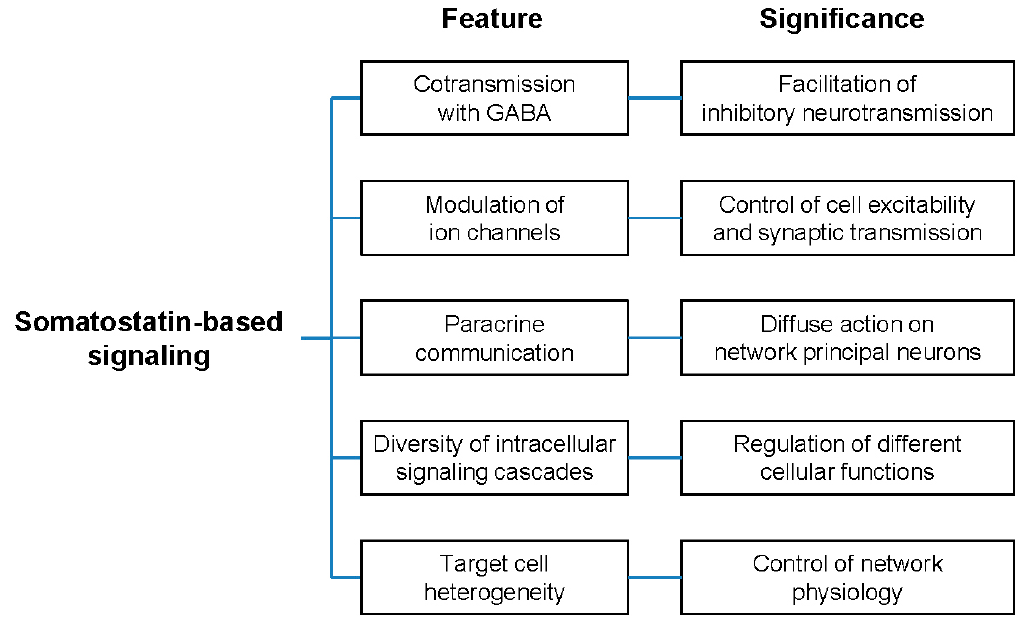
Figure 8. The complexity of somatostatin-based signaling in the retina and hippocampus.